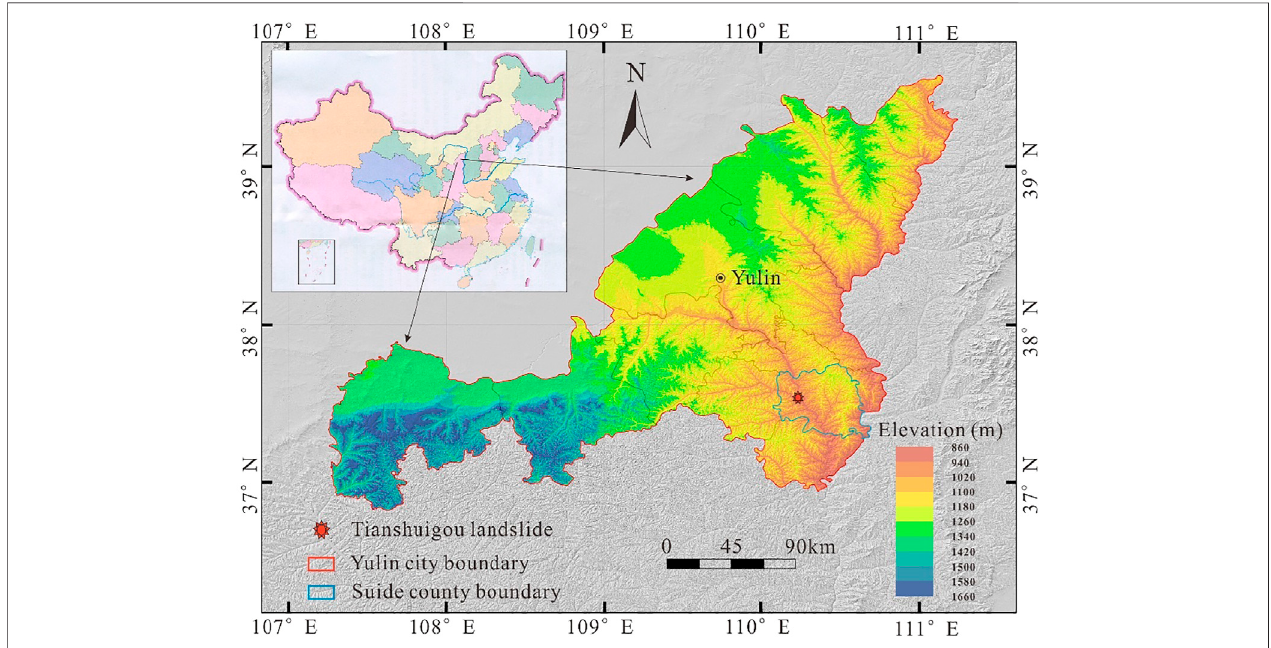
FIGURE 1 | Location of the study